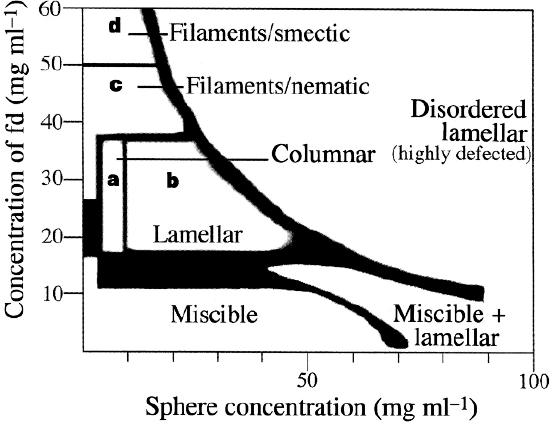
Figure 11. Phase diagram for fd virus and 100 nm polystyrene spheres. Reprinted with permission from Springer Nature: Nature, Entropically driven microphase transitions in mixtures of colloidal rods and spheres, Adams, M.; Dogic, Z.; Keller, S.L.; Fraden, Copyright (1998) [104] .